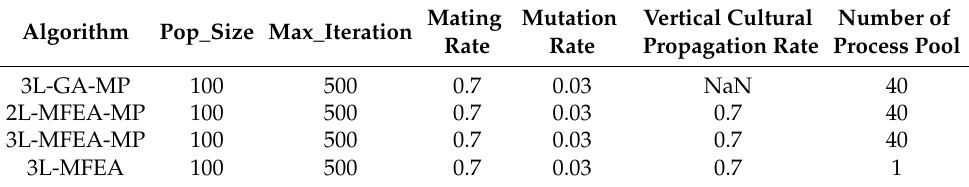
Table 1. The main parameters of the experiment.